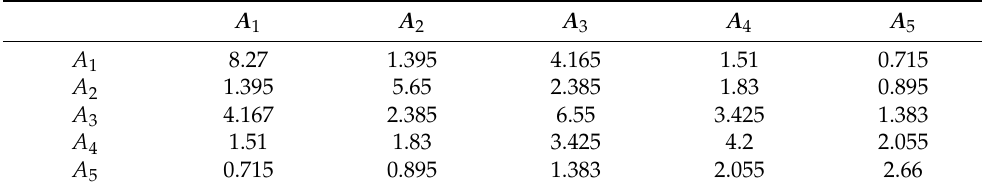
Table 6. Contact frequency